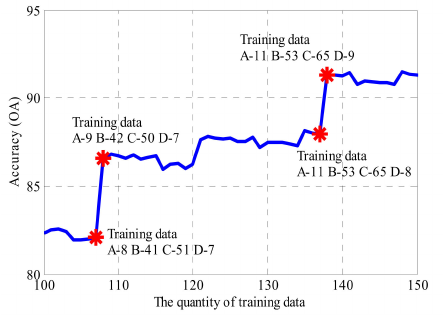
Figure 20. The OA of the KNN method when K =